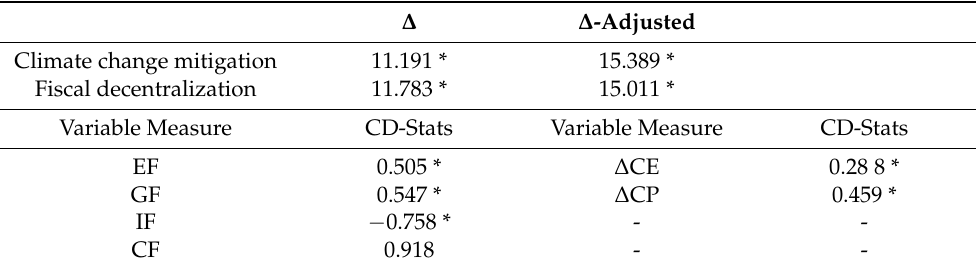
Table 1. SCH and SCI diagnostics.